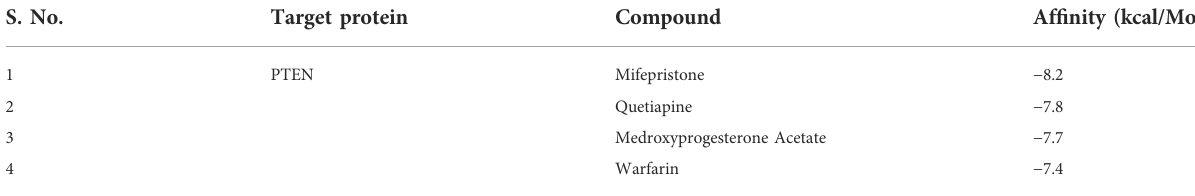
TABLE 4 Table representing binding af fi nity and inhibition constant for the interaction of four drugs with PTEN. S.